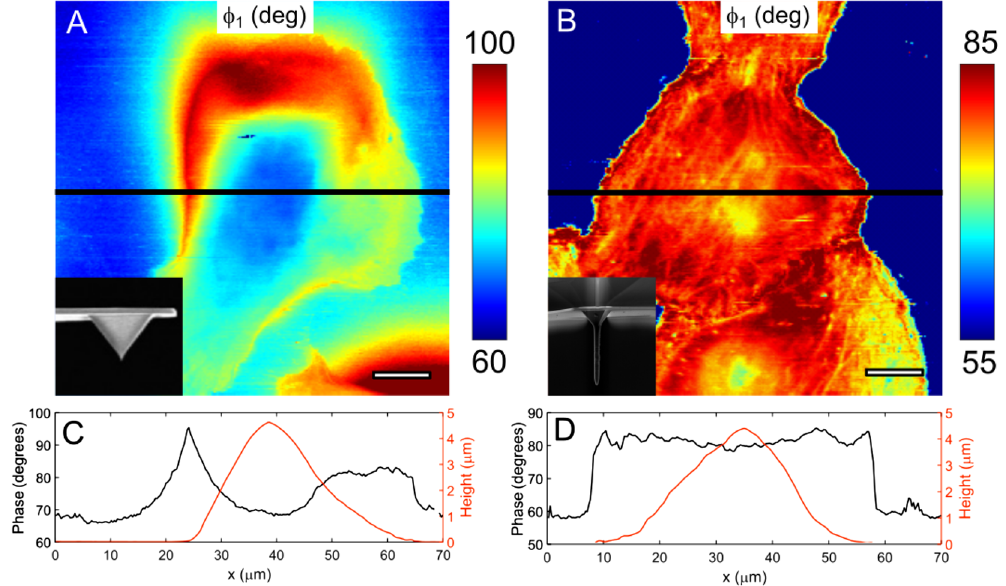
Figure 2. Cantilevers with long tip reduce topography convolution observed in phase images. ( A ). Phase image of a tall (~ 5 µm) MDA-MB-231 cell. Phase increase beyond the cell is seen in the top part of the image caused by the hydrodynamic interaction between the cell surface and the cantilever beam behind the tip. ( B ) This effect is not presented when using the long tips; the contrast is higher, cytoskeleton fibers and nucleoli could be distinguished. Insets: SEM image of the tip. ( C ) Cross-section of the phase signal along the black line indicated in ( A ) showing the effect of the phase signal affected by the topography for the standard tip. The phase value is lower over the highest part of the cell (lower hydrodynamic drag). ( D ) Cross-section of the phase signal over the marked line in ( B ), long tip. The phase does not noticeably correlate with the